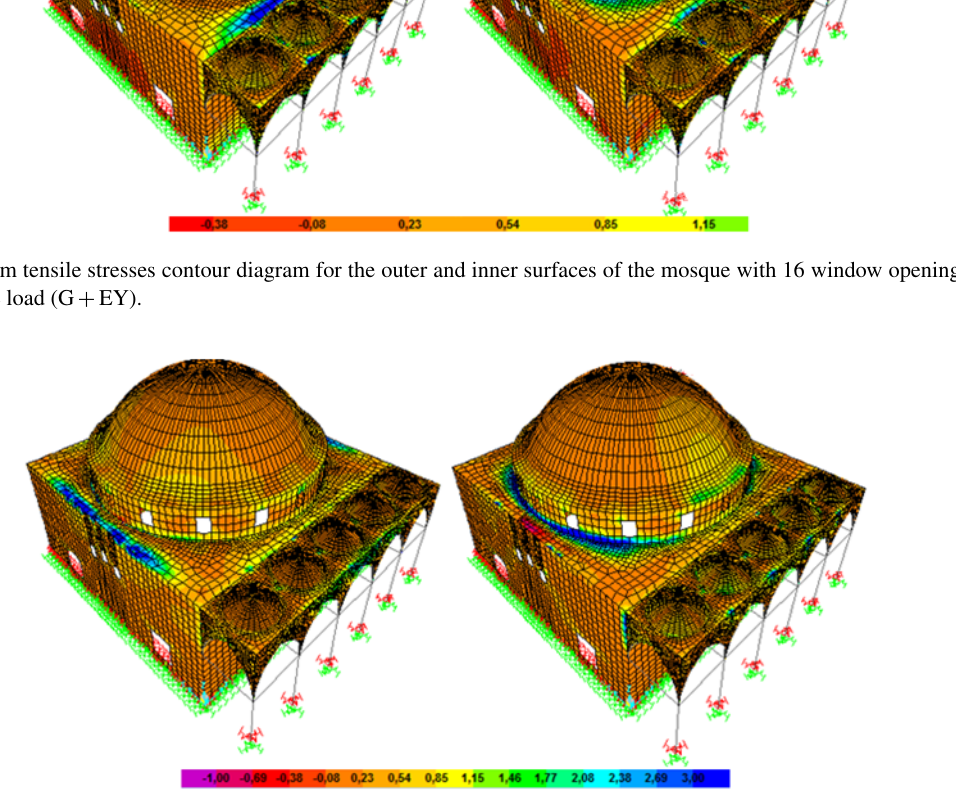
Figure 11. Maximum compression stresses contour diagram for the outer and inner surfaces of the mosque with 16 window openings under dead load and earthquake load (G + EY).